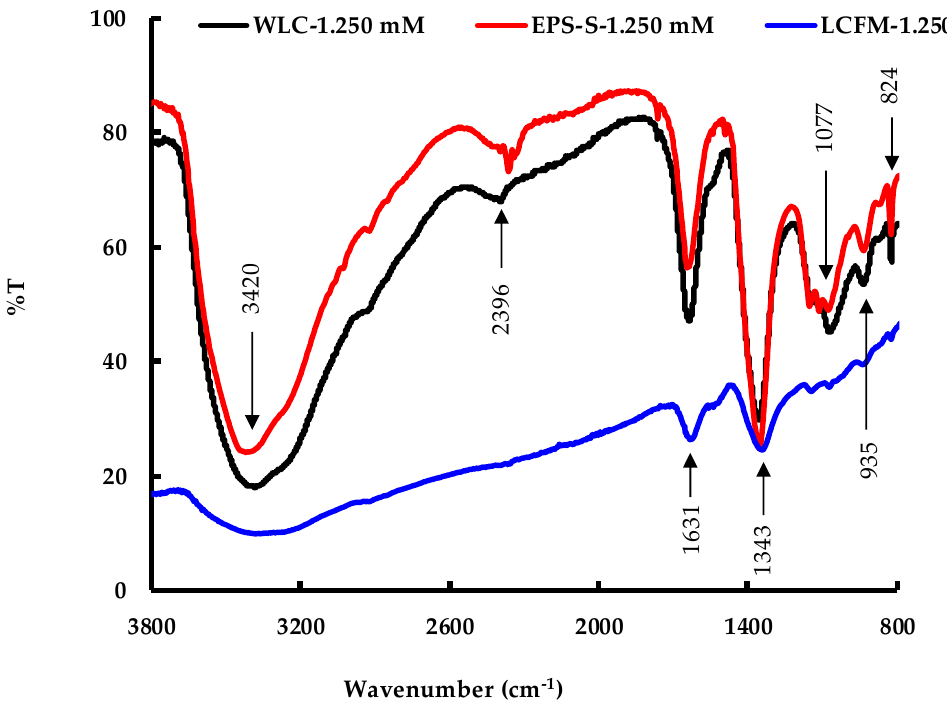
Figure 9. FTIR on the AgNPs produced by WLC-1.250 mM, EPS-S-1.250 mM and LCFM-1.250 mM.